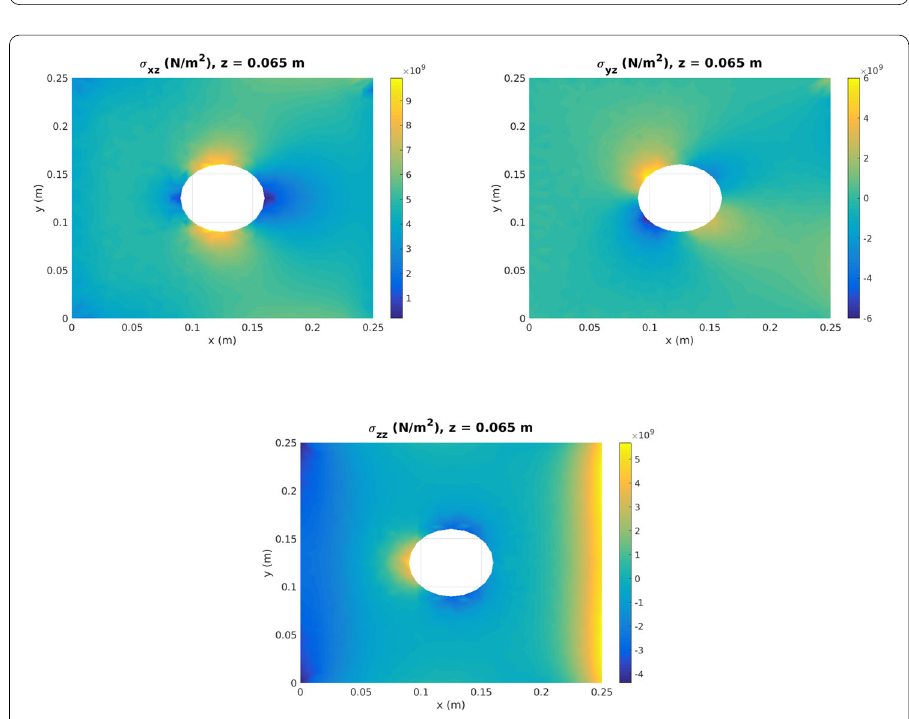
Fig. 6 Out-of-plane stress tensor components in the z = 65 mm plane using the minimally-intrusive fully 3D separated plate